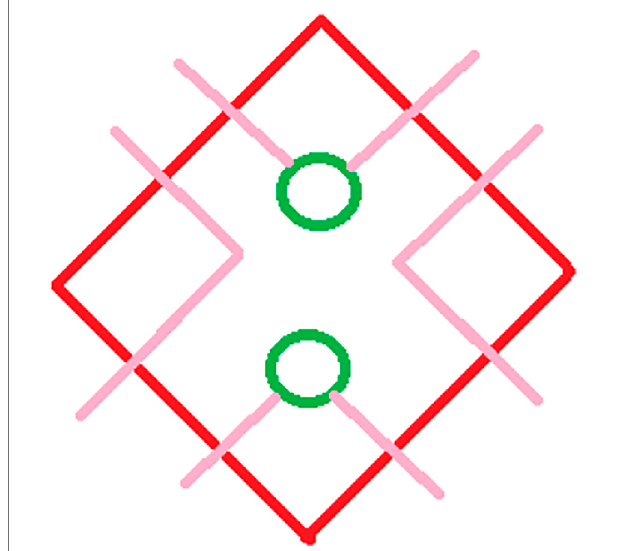
FIGURE 2 | Resulting vertex after the integration over matrix B . The double pink lines indicate the propagator and the green circles indicate the insertion of the matrix C in the